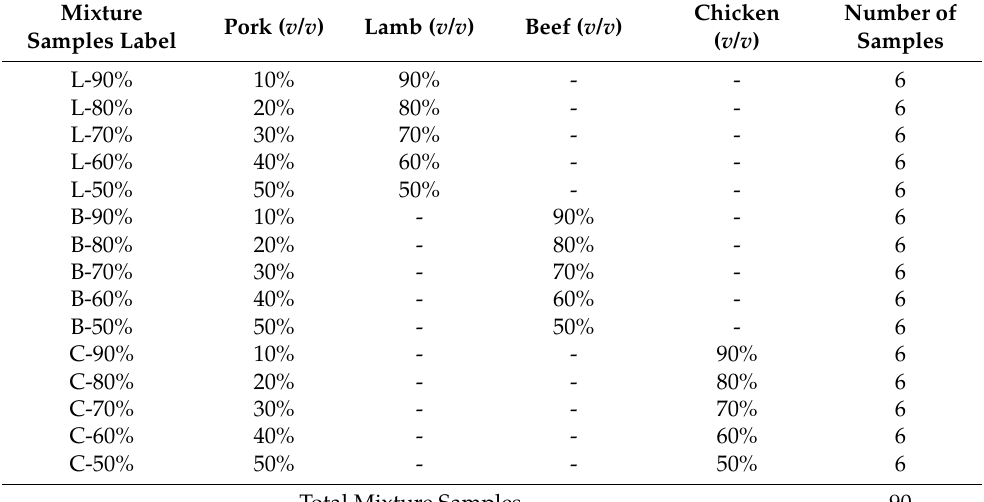
Table 3. Composition of adulterated samples with the ratio of lard mixed with samples of beef, lamb, and chicken, represented by their initials (Lamb: L-90% to L50%, Beef: B-90% to B-50%, Chicken: C-90% to